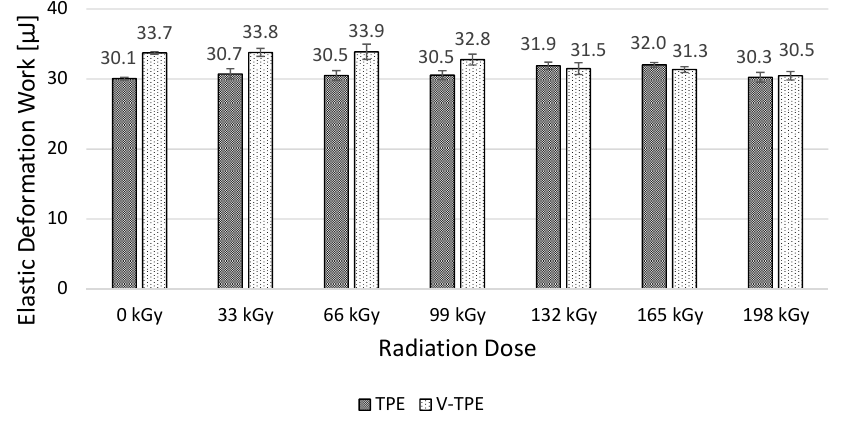
Figure 7. Elastic deformation work—TPE,